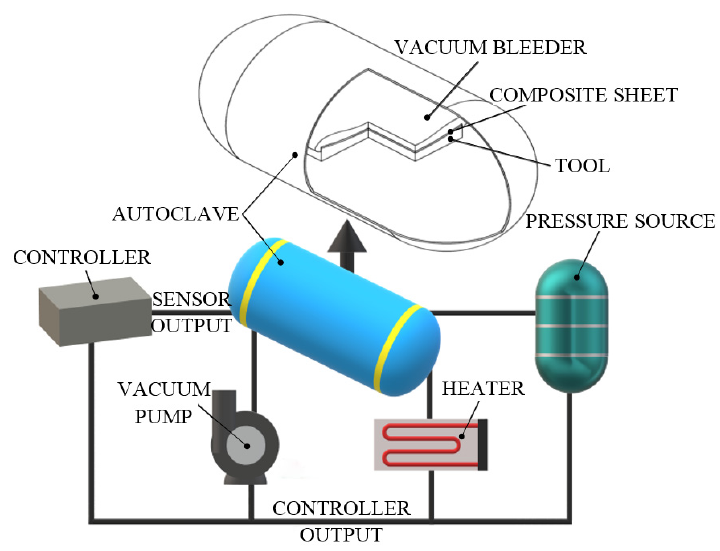
Figure 14. The schematic diagram of the autoclave molding process. AM is a manufacturing technique that uses a two-sided mold set that forms both outer surfaces of the FRP composite panel. On the upper side of the mold, a flexible silicone/nylon membrane is used, while on the bottom side there is a rigid mold. The con- tinuous reinforcement material (unidirectional tapes and plies, prepreg fabrics or woven cloths), usually pre-impregnated with the resin, can be placed inside the mold automati- cally (using robots) or manually. In some cases, the lower half-mold is coated with a thin film of resin, and the dry reinforcement is placed on it. Further, the upper half-mold is installed, and vacuum is applied to the mold cavity, where a vacuum pump evacuates the entrapped air. This process eliminates volatile products and air inclusions from the FRP part. The whole assembly is then placed inside an autoclave. Generally, this process is performed at both high temperature and high pressure. The use of inert gas pressure facilitates material curing, a low void content and high fiber volume fraction (densification of the material) for maximum FRP structural efficiency. The vacuum-to-autoclave pressure cycles are chosen to allow maximum air removal without incurring excessive resin flow. The vacuum is commonly applied only in the early stages of the curing cycle, while autoclave hydrostatic pressure (normally in a range of 3–12 MPa) is maintained through ‐ out the entire heating ‐ to ‐ cooling cycles. Following the AM process cycle, the modeled composite is removed sequentially from the autoclave and mold cavity. Autoclave curing allows the manufacture of consistent homogeneous composite products.